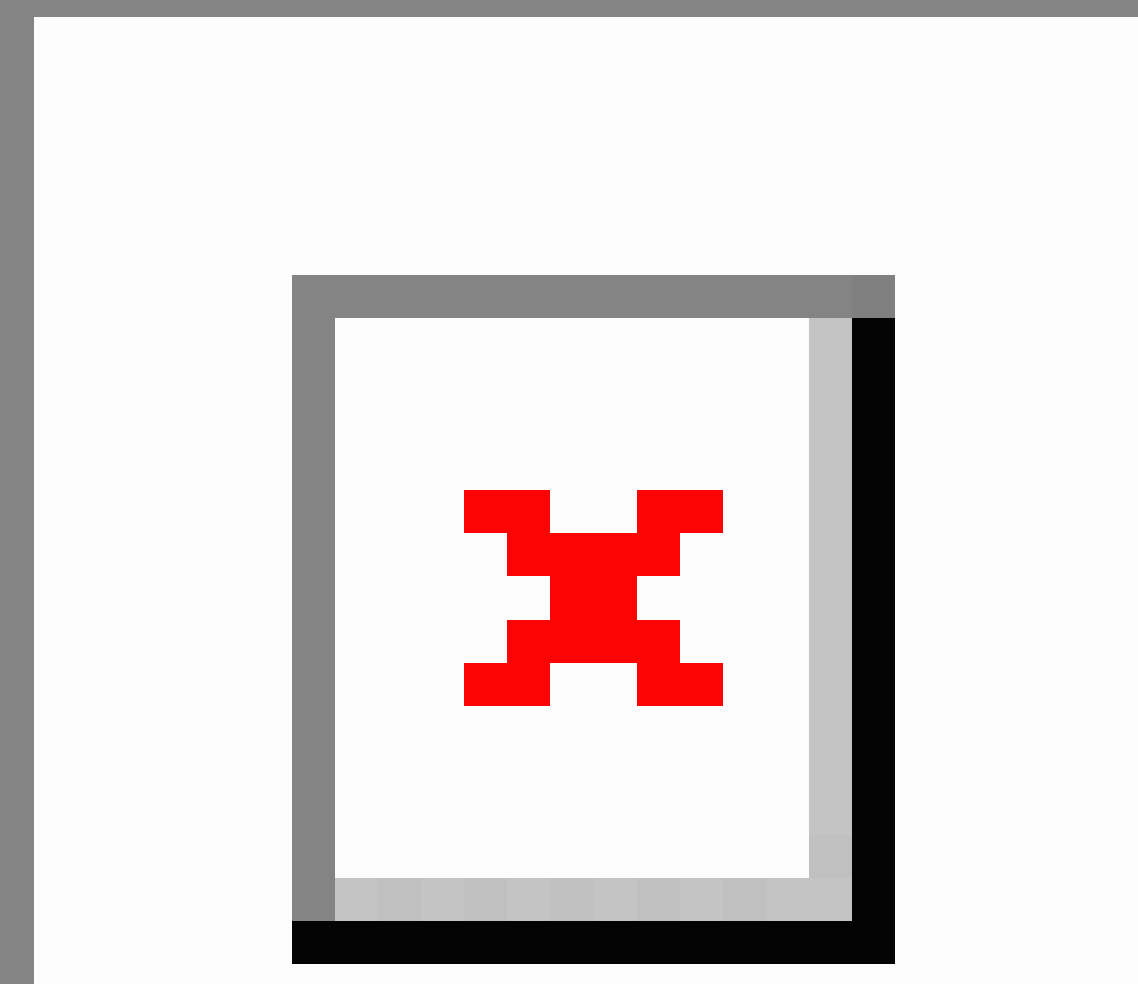
Figure 3. On an iOS device, an NCCT brain scan shown in image a was incorrectly interpreted as having a dense MCA sign (arrow). On an iOS device, a CT angiography brain scan (image b ) demonstrates a normal patent vessel. On the workstation monitor, an NCCT brain image c shows nearly the same Hounsfield units (open rectangles) of both vessel segments, thus avoiding the error made on the iOS